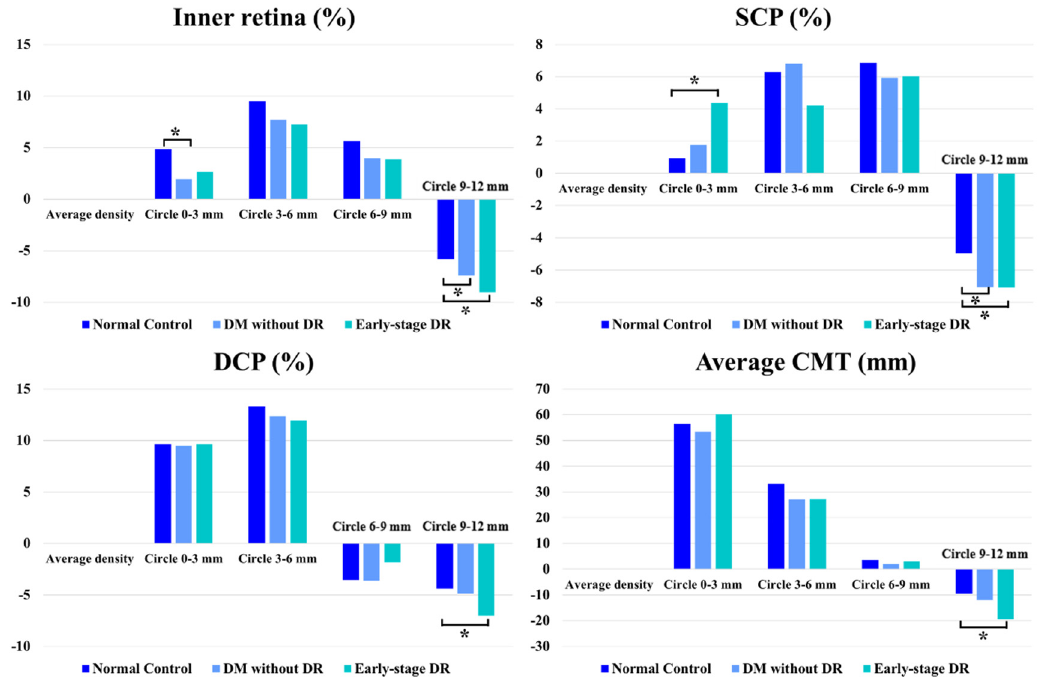
cally significant difference ( p < 0.05).